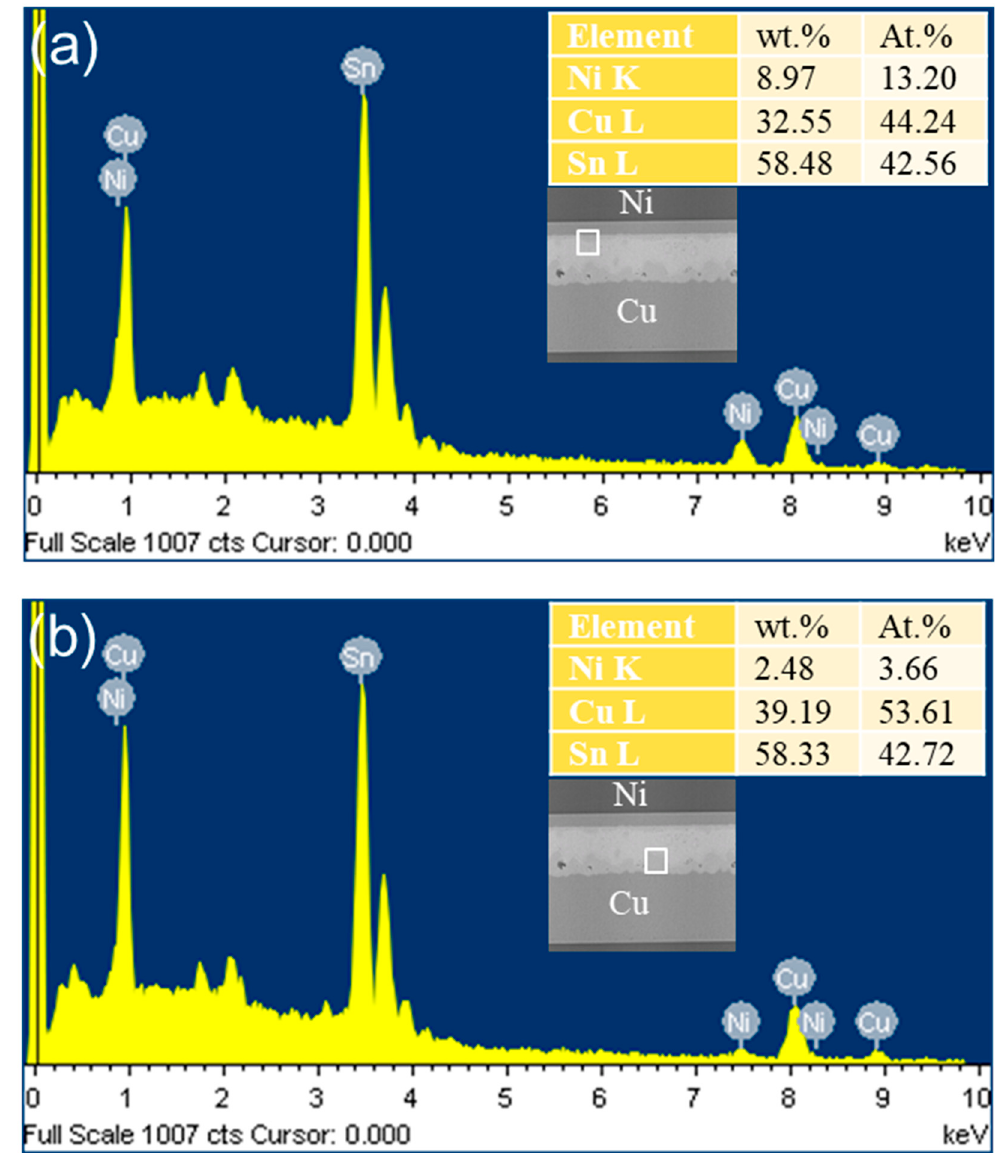
Figure 6. EDX (Energy dispersive X-ray spectroscopy) analysis of the IMCs on the ( a ) Ni and ( b ) Cu sides of the Ni/solder/Cu microbump after 2000 TCT cycles. The white square indicate the chosen locations for the EDX measurements.